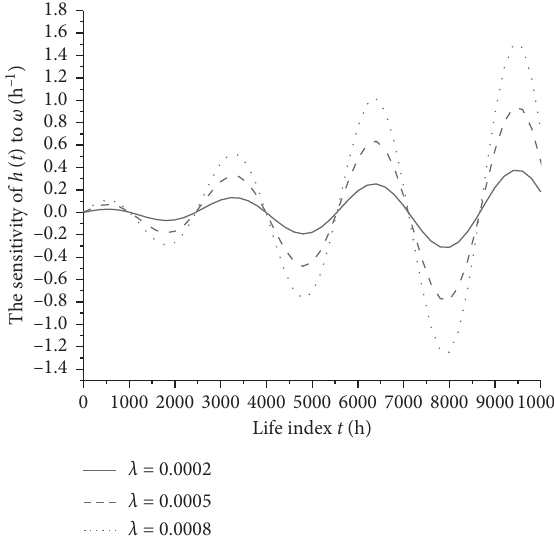
Figure 22: The sensitivity of f ( t ) to 2 ω ( λ � 0.0002/0.0005/0.0008).